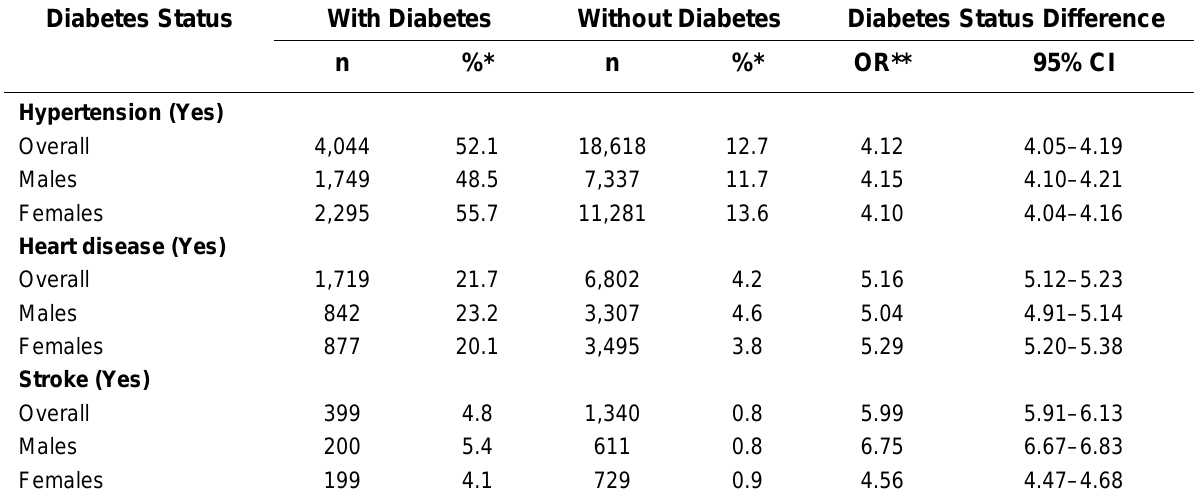
Prevalence (%) of Self-Reported Cardiac Comorbidities Among Diabetes Compared to Nondiabetics by Sex Among Canadians 12 Years of Age and Over (CCHS, Canada, 2003) With Diabetes Without Diabetes Diabetes Status Difference Diabetes